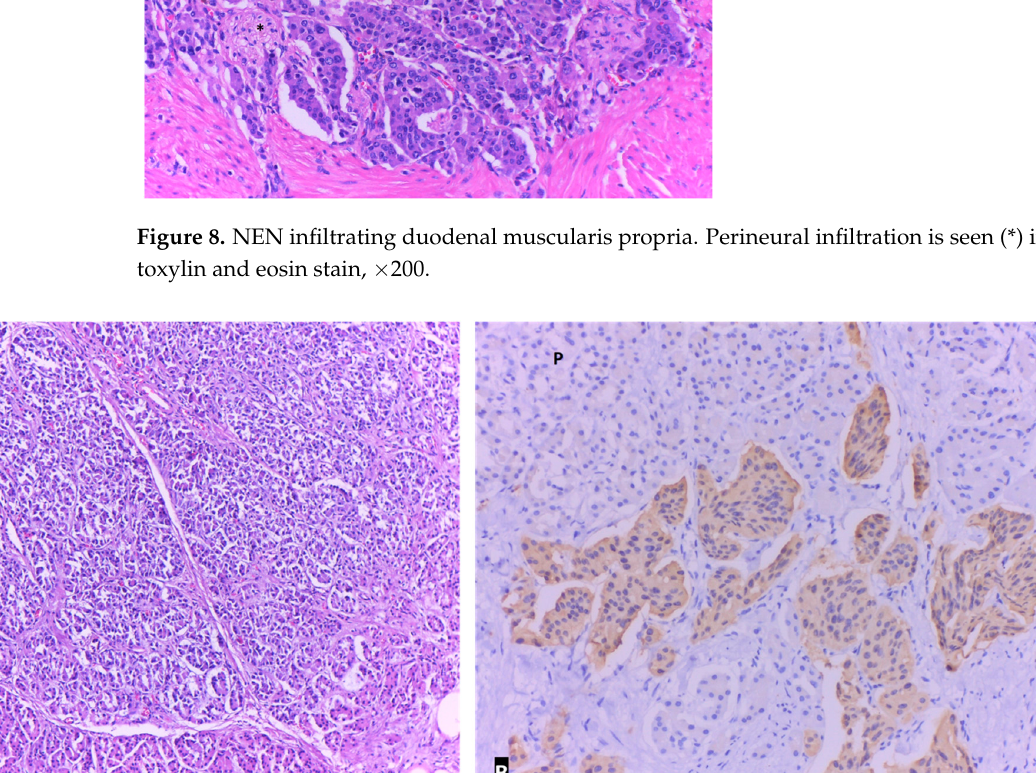
Figure 9. NEN infiltrating the pancreas (normal acini are seen in the lower left corner) in Hematoxylin and eosin stain, ×100: ( A ) NEN infiltrating the pancreas (P); Nests of tumor cells with bland nuclei without nucleoli. Immunohistochemical staining for Cromogranin A, ×400 ( B ).